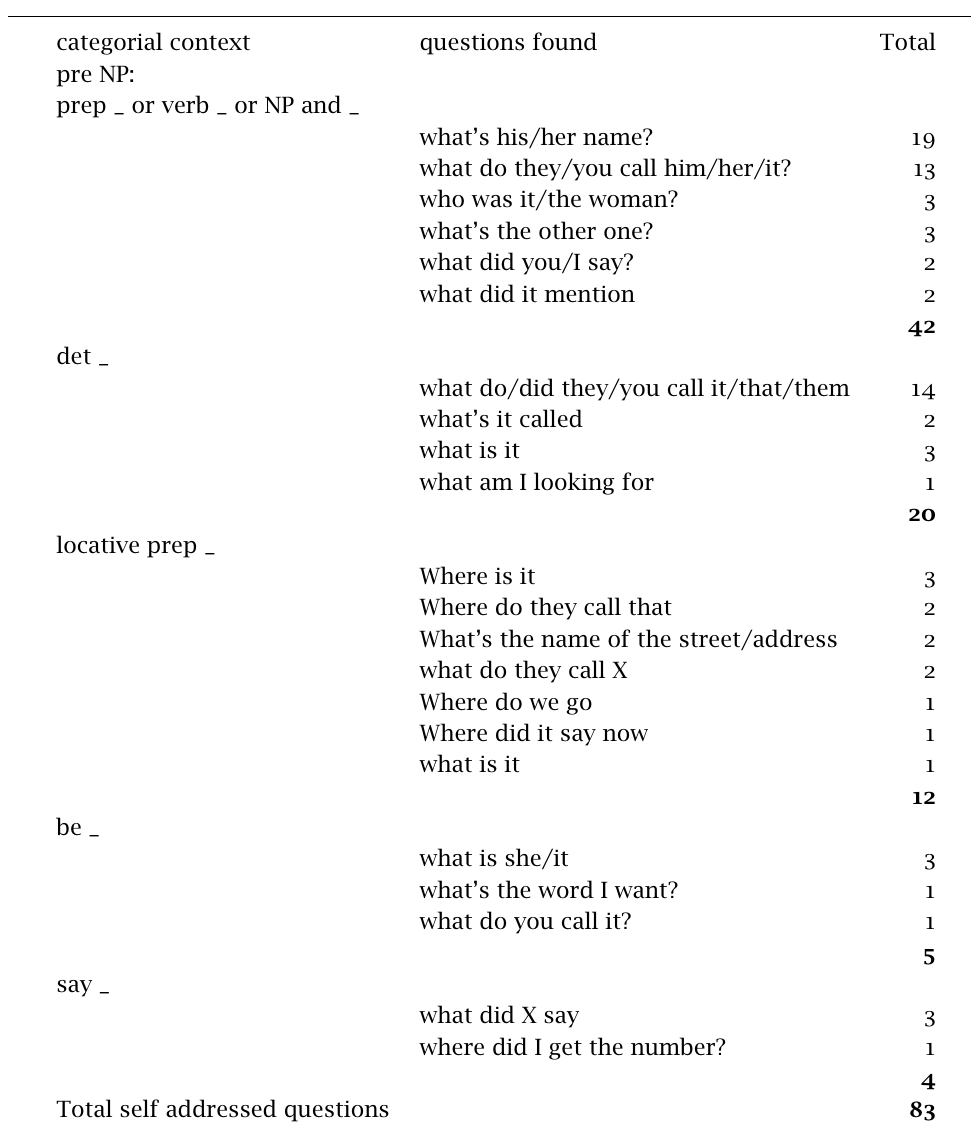
Self addressed questions in disfluencies in the British National